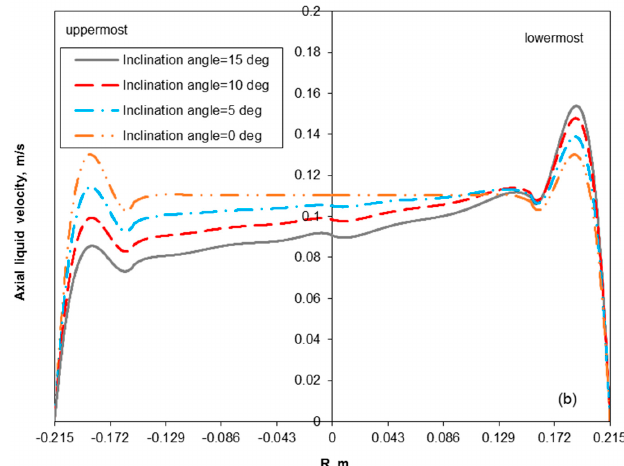
Figure 12. Steady-state radial profiles of axial liquid velocity in x -axis (see Figure 1)—vertical and inclined seawater scrubbers (Packed-bed column with Raschig super-Rings; H = 5 m; z/H = 0.8): ( a ) Pressure = 1.5 MPa; ( b ) Pressure = 2.5 MPa.